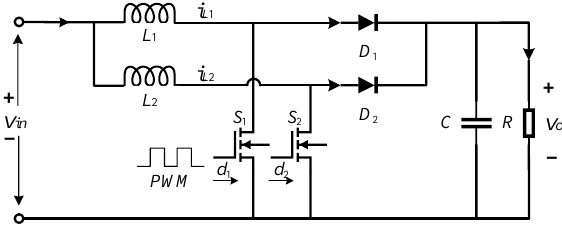
Figure 1. The topology of TIBC.